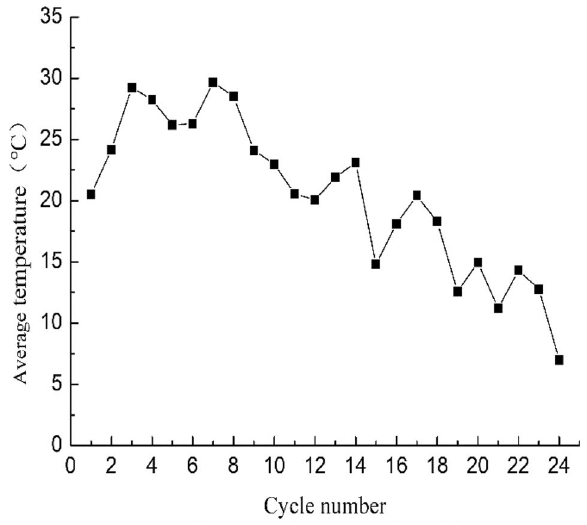
Figure 2. Average air temperature during each soaking treatment. The figure created by OriginPro 2021, http:// www. Origi nlab. com/ Origi nProL earni ng. aspx (the same of Figs. 3, 4 and 5).